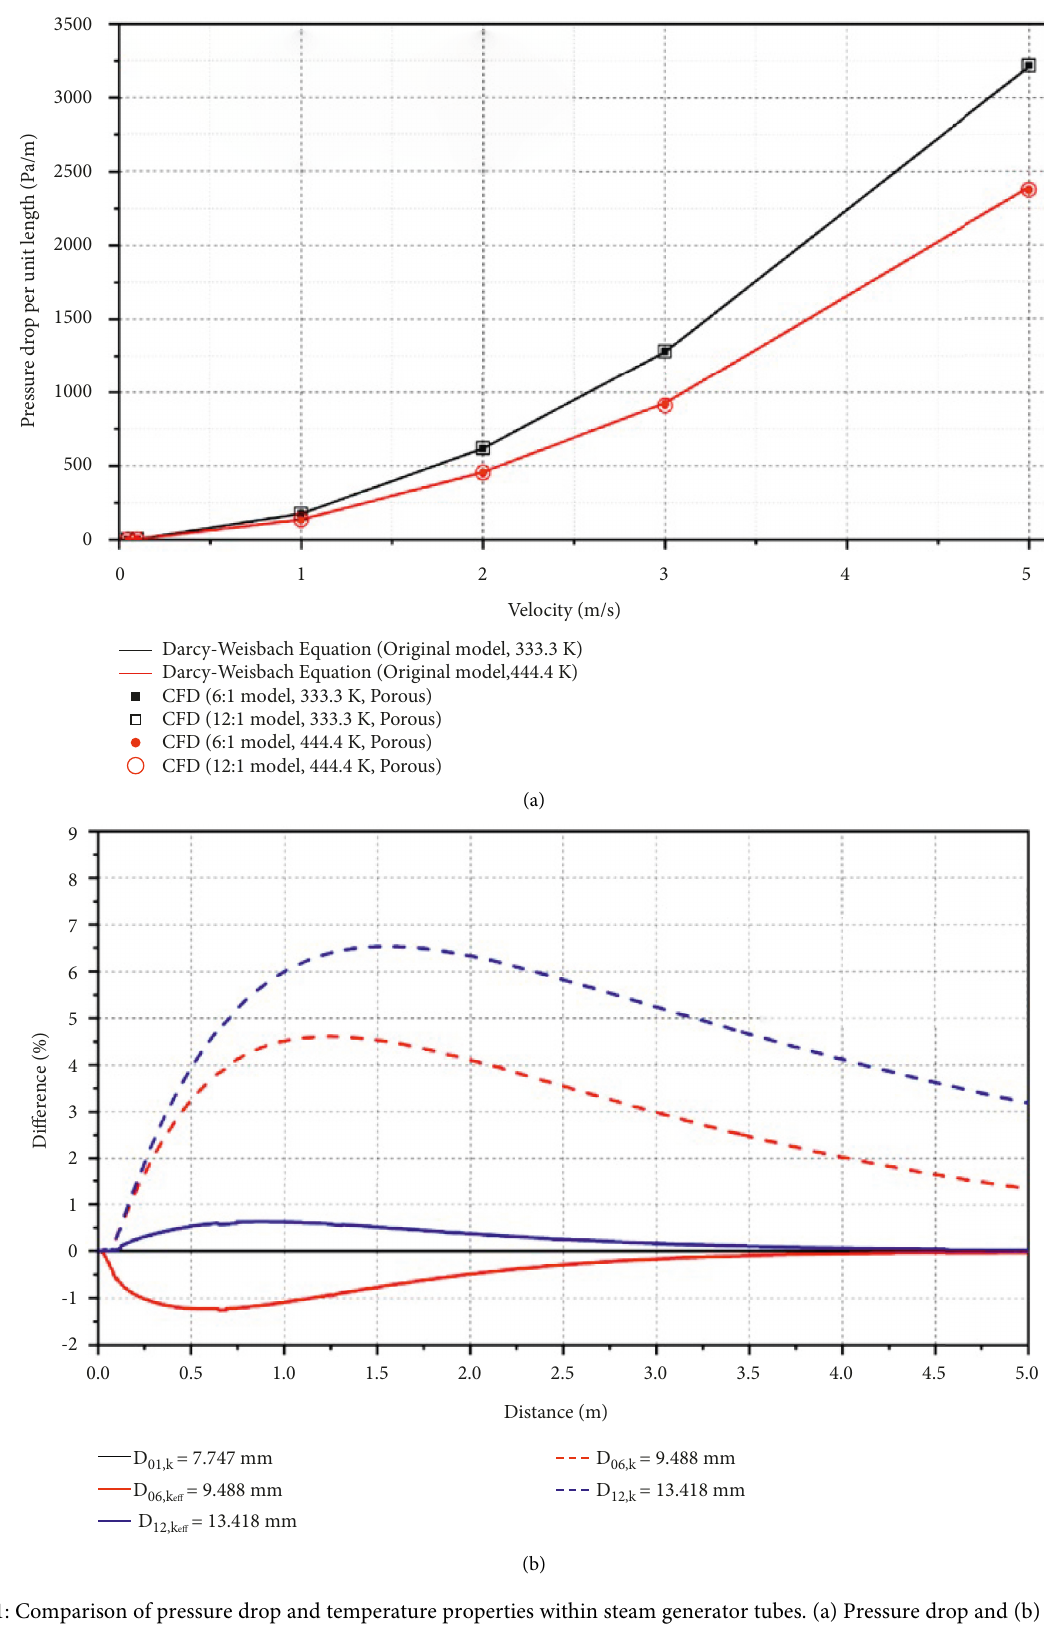
Figure 11: Comparison of pressure drop and temperature properties within steam generator tubes. (a) Pressure drop and (b) temperature